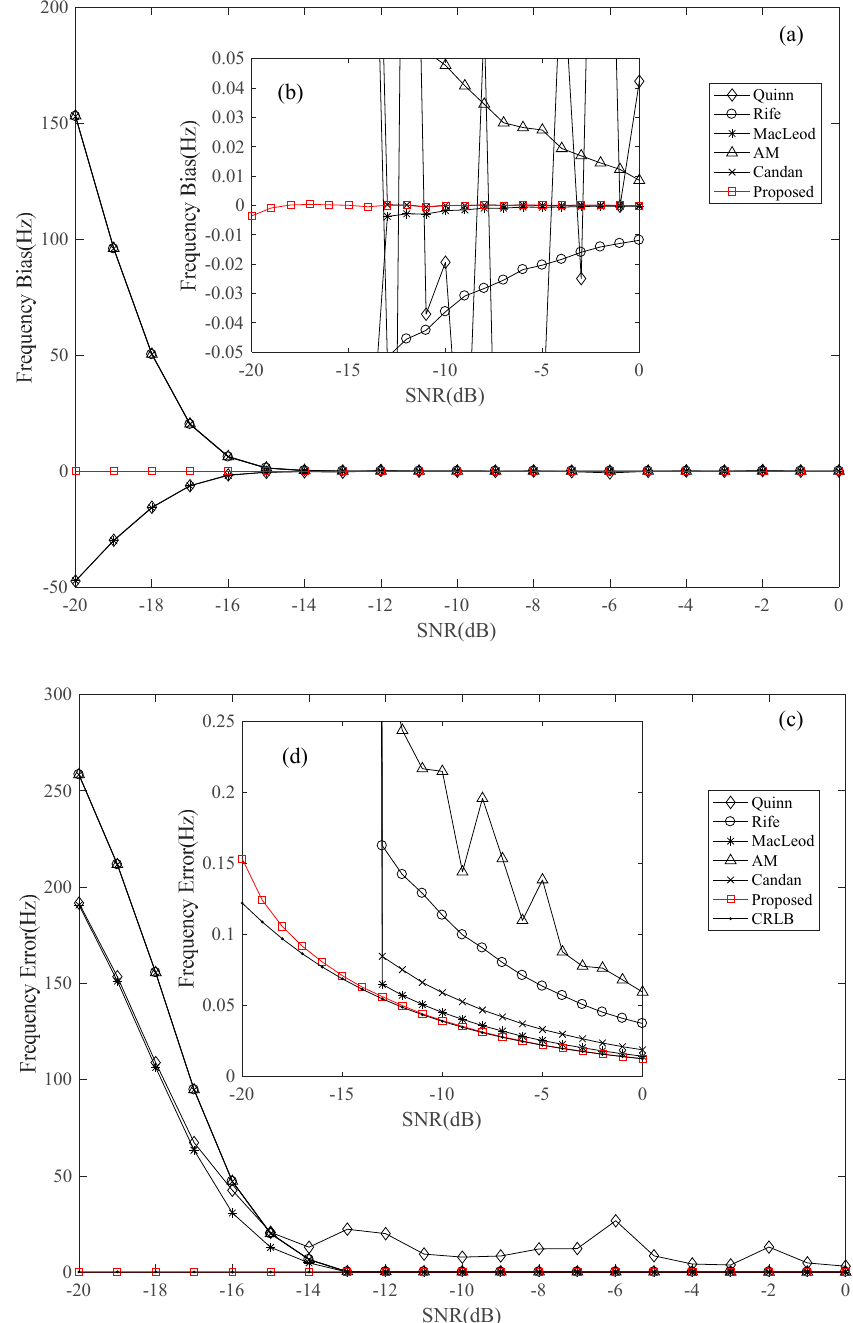
Figure 4. Frequency estimation performance compared with five traditional estimators and CRLB. ( a ) Frequency estimation bias; ( b ) the enlarged view of ( a ); ( c ) Frequency estimation error; ( d ) the enlarged view of ( c ).